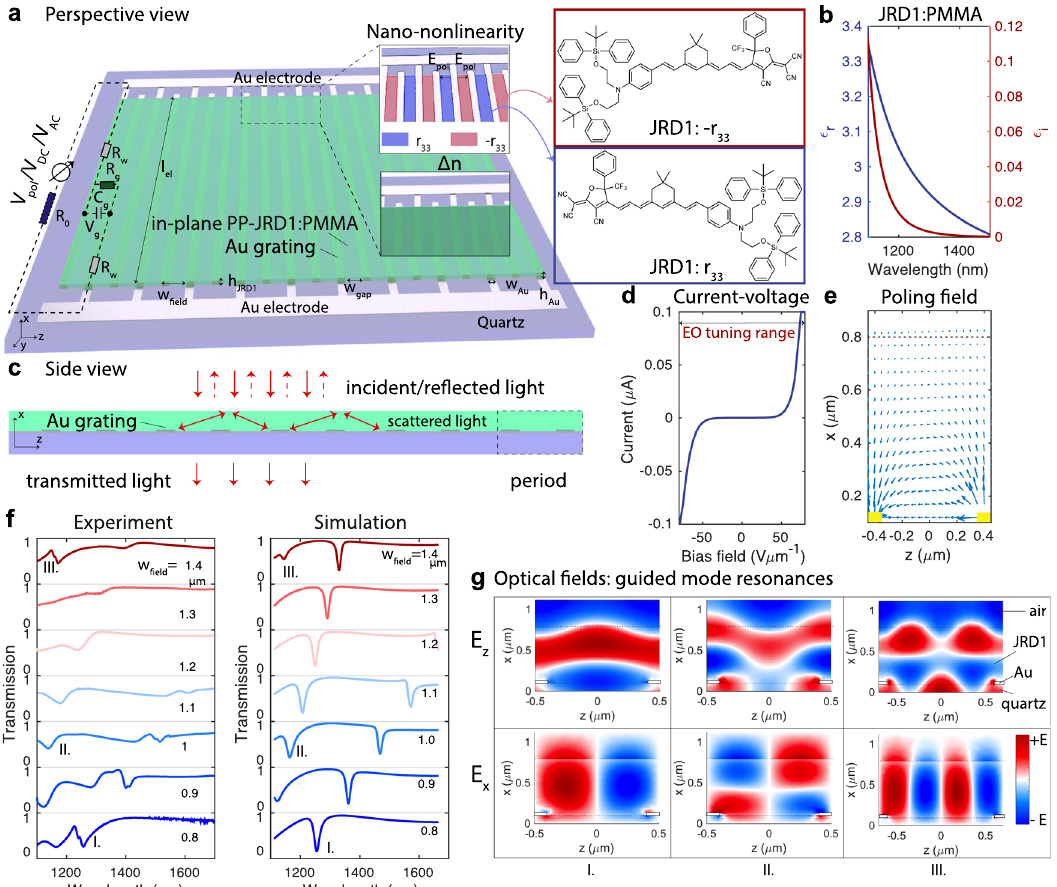
Fig. 2 Optical and electronic properties of the resonant electro-optic modulators. a An array of metallic stripes with h Au = 40 – 50 nm is patterned onto a quartz substrate and covered by a layer of organic electro-optic molecules JRD1 (see inset) mixed with PMMA of optical constants as shown in b . The electro-optic effect is accomplished by applying a poling bias to the fi lm using the interdigitated array as described in the “ Methods ” section. The opposite direction of the poling fi eld in adjacent periods is used to engineer an overall periodically poled fi lm with alternating r 33 (blue) and − r 33 (red) at the nanoscale. Considering also the driving RF or DC fi elds, an overall homogenous refractive index change Δ n is achieved in all unit cells (green, see inset). The frequency-dependent electrical characteristics are modeled by a simpli fi ed equivalent circuit from R w , R g , R 0 , and C g . c The array of metallic stripes spaced by w fi eld = 0.8 − 1.4 μ m (displayed in different colors) sustain guided mode resonances inside the layer of JRD1:PMMA. They result from light scattered into different grating orders being guided in the slab formed by the air-JRD1:PMMA-quartz stack and subsequently reemitted. d Current – voltage characteristics of the junction feature bi-directional Schottky barriers formed at the metal-organic interface. The current is below 100 nA throughout the entire electro-optic tuning range up to the poling voltage of 100 V at w gap = 1.2 μ m. e The poling fi eld has a strong component in the z -direction, as shown by the fi eld plot. The arrows indicate the direction and magnitude of the poling fi eld. f The optical characteristics of the guided mode resonances are characterized experimentally and compared to the simulated results at perfectly normal incidence, which reproduce well the resonant wavelengths of the three modes. The low quality factor and depth of mode II. and III. in both measurements and simulations are attributed to losses of JRD1:PMMA ( ϵ i in d ) that increase dramatically close to 1100 nm. g Electro-magnetic simulations from CST Microwave studio show the real part of the x-components and z-components of the three optical modes that form within the active layer in the wavelength range from 1100 to 1700 nm, given the geometric parameters. EO electro-optic, PP-JRD1:PMMA periodically poled JRD1:PMMA, Ti titanium, Au gold, R 0 external resistor, C w resistance of one single metallic wire, R g resistance between one single pair of metallic wires, C g capacitance between one single pair of metallic